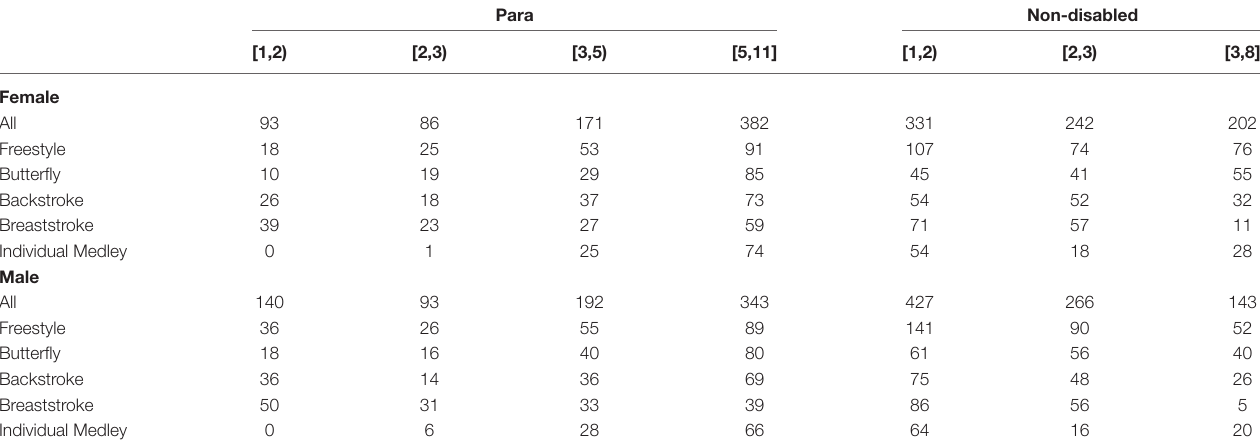
TABLE 2 | Number of performances by stroke style (all distances combined) and involvements in group events for Para and non-disabled female’s and male’s